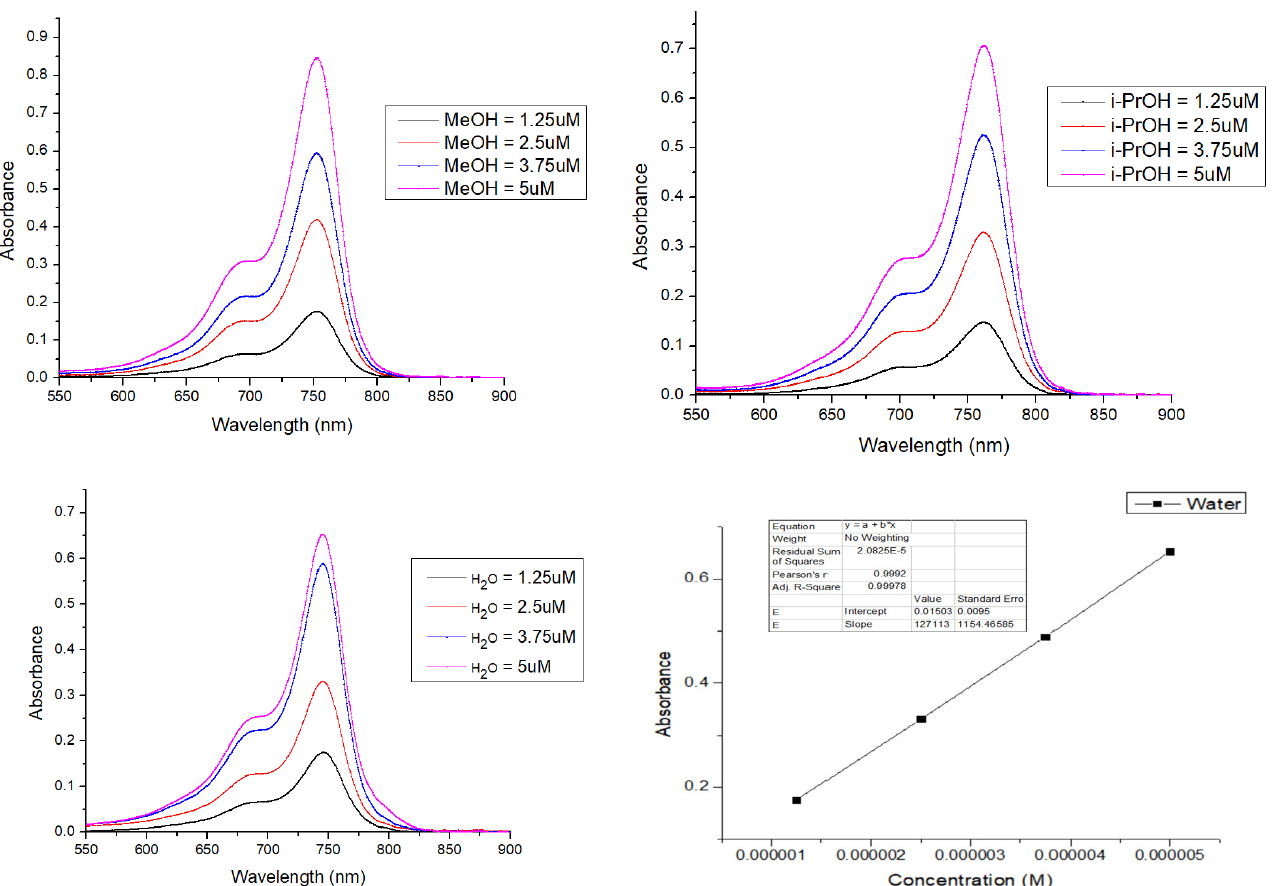
Figure 1. Absorbance profile of ERB-60 in polar protic solvents at different concentrations (1.25 µ M, 2.5 µ M, 3.75 µ M, 5.0 µ M). The absorbance increase was linear with respect to concentration and follows the Beer–Lambert law with the extinction coefficient being calculated from the linear regression as ε = 127,113, 151,360 and 172,240 M − 1 cm − 1 in water, isopropanol, and methanol, respectively.